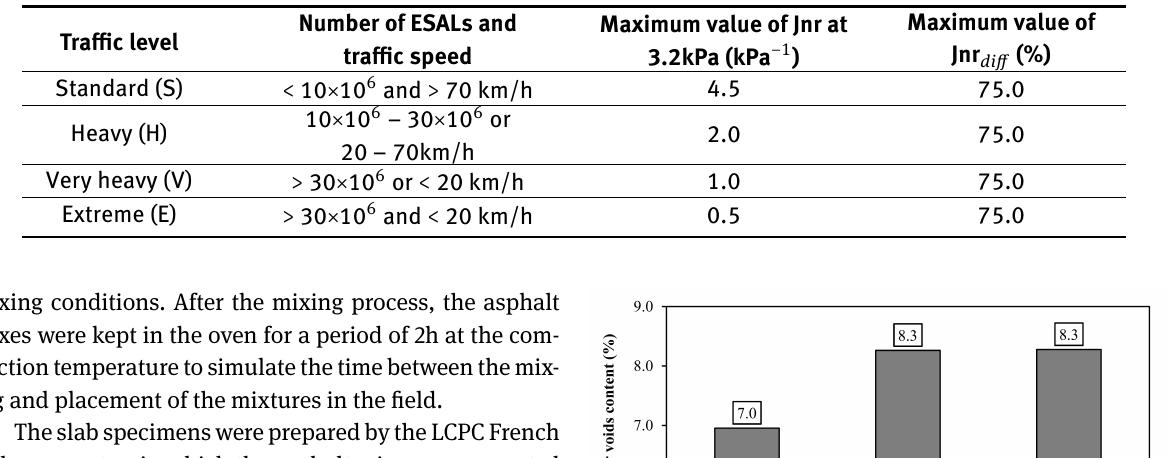
Table 1: Traflc level according to Jnr (AASHTO M 332, 2014)